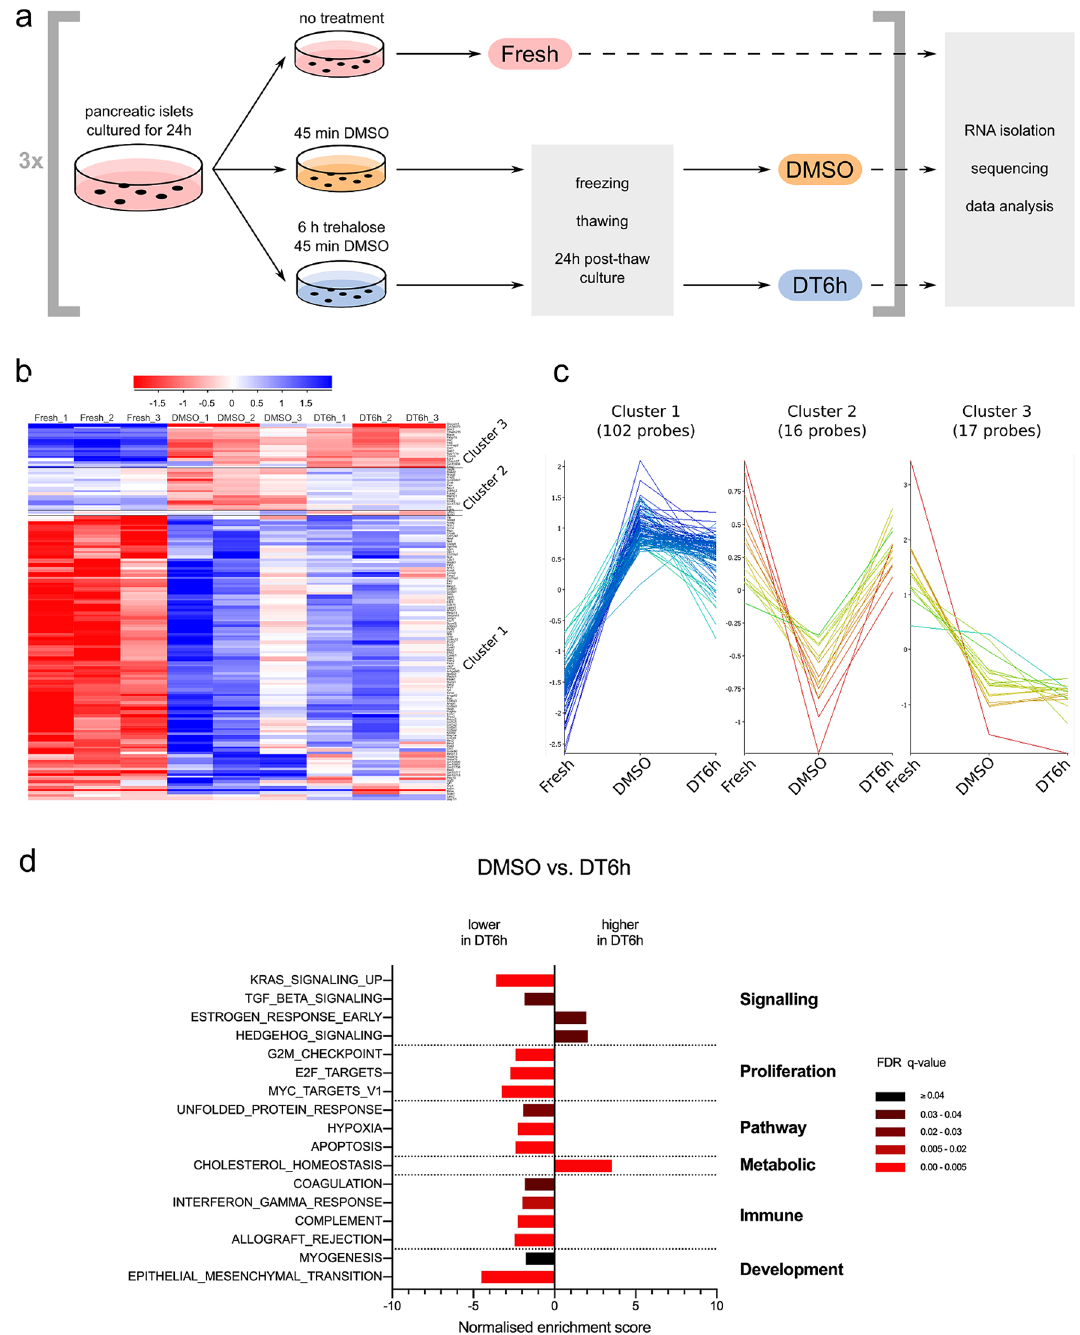
Figure 7. Impact of cryopreservation on islet transcriptome. ( a ) Schematic representation of the experimental design. Islets from three separate isolations (n = 3) were used as shown and samples were stored in RNAlater solution. RNA from all samples was processed and sequenced on the same occasion. ( b ) Heatmap showing the 142 genes that are differentially expressed between the three tested conditions (genes common to both the DESeq2 and Intensity Difference analysis, FDR ≤ 0.05, n = 3 islet isolations, individual replicates shown), clustered based on the hierarchical cluster analysis. ( c ) Line graph representation of the gene clusters 1, 2 and 3, re-plotted from ( b ). ( d ) Preranked Gene Set Enrichment Analysis (GSEA-Preranked) of relative differences in Hallmark gene set expression levels between DMSO- and DT6h-cryopreserved islets (differences of FDR ≤ 0.05 are shown). The gene sets are grouped according to the Process Categories of the Molecular Signatures Database Hallmark Gene Sets (see “Methods”). FDR q-values are highlighted in different shades of red. Figure ( a ) was created using Inkscape (version 0.91, http:// www. inksc ape. org/), figures ( b ) and ( c ) using SeqMonk 39